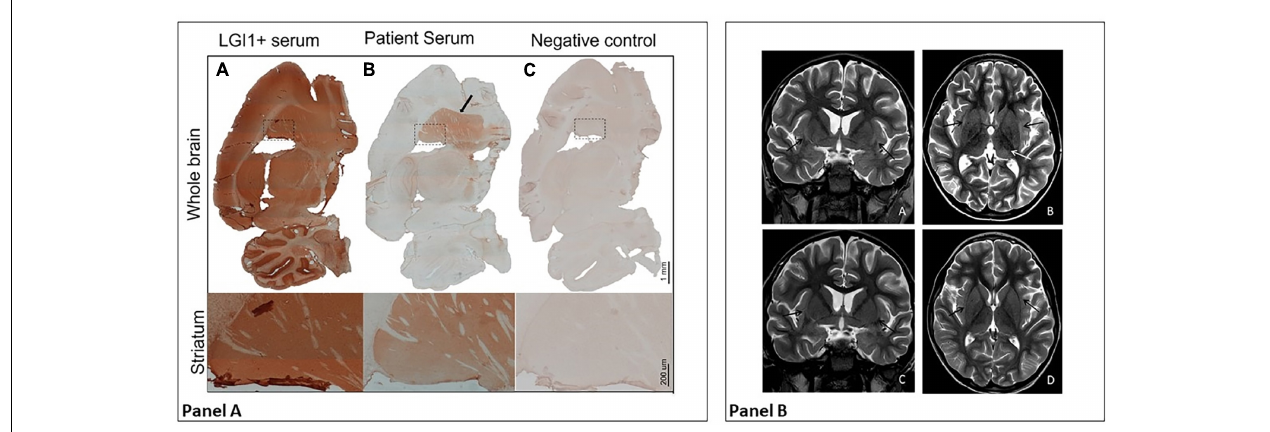
FIGURE 2 | Panel (A) Diffuse staining is typical of certain anti-neuronal antibodies, such as anti-LGI 1 antibodies (A); in their presence, staining involves the hippocampus, cerebellum, thalamus, striatum (shown in detail), and cortical areas. The patient’s serum shows LGI1-like staining, but with selective involvement of the striatum (B, in detail). As shown in (C), no staining is observed with a control serum. Panel (B) MRI at day 40 (first row) vs. follow-up MRI 2 weeks later (second row). In the first row, axial and coronal T2-weighted images (A,B) show bilateral slight enlargement and hyperintensity of the claustrum (black arrows) and mild T2 hyperintensity of the left thalamic pulvinar (white arrow). Also note the diffuse widening of the pericerebral CSF spaces. After 2 weeks, axial and coronal T2-weighted images (C,D) show complete resolution of signal alterations and a quite normal appearance of the pericerebral CSF